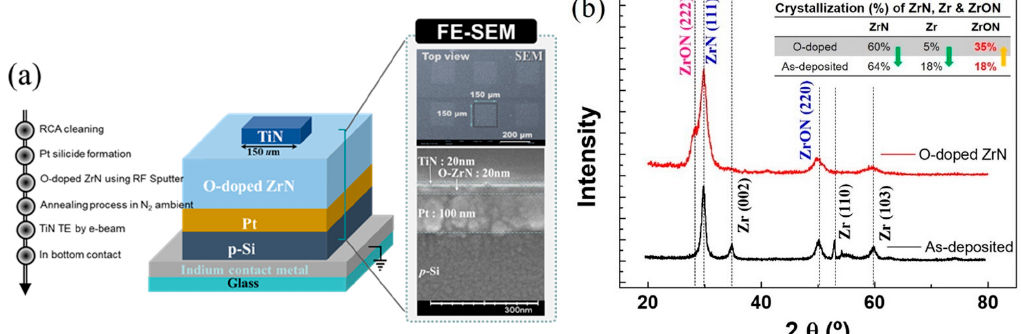
Figure 1. ( a ) (left side) Device schematic diagram of PtSi/ O-doped ZrNx/TiN RRAM cell and manufacturing procedure. (B) (right side) Cross-sectional image and top view of fabricated device measured by FE-SEM. ( b ) X-ray diffraction (XRD) curves measured for O-ZrN films annealed in the scan range of 20°–80°. Inset table shows crystallinity of ZrN, Zr, and ZrON using Hinrichsen’s method.